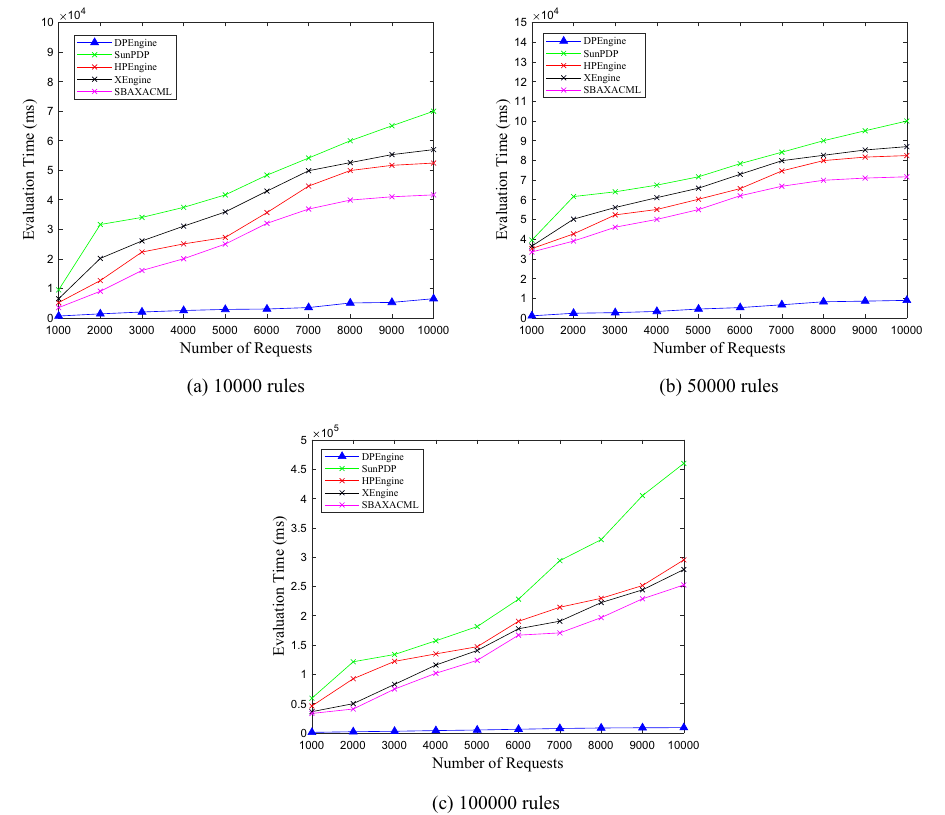
Figure 11. Evaluation performance on ASMS policy